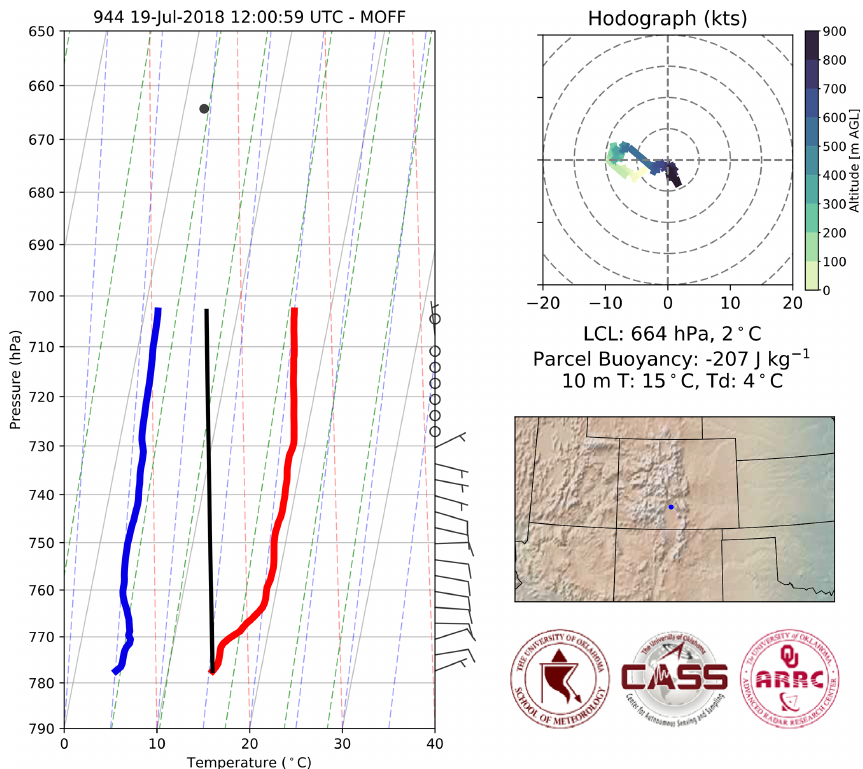
Figure 10. Skew-T log-p plot of temperature (red line) and dew point (blue line) generated from a single CopterSonde flight. The surface- based parcel process curve is also included (black line). A hodograph in the upper right corner shows the wind speed and direction over height. Also included are some basic thermodynamic air parcel properties and a map of where the profile was measured. Map is generated using the open-source Basemap package, which references the Generic Mapping Tools dataset (Wessel et al., 2013) for state borders.